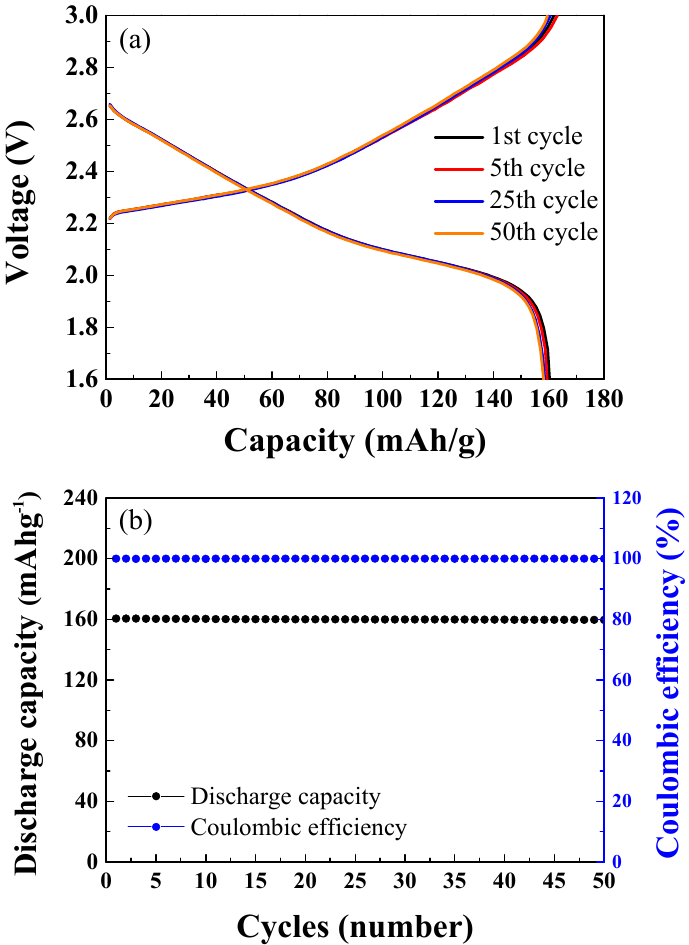
Figure 4. ( a ) Cycle performance of the NCM-LTO full-cell over 50 cycles. ( b ) Discharge capacity and coulombic efficiency of the NCM-LTO full-cell over 50 cycles.